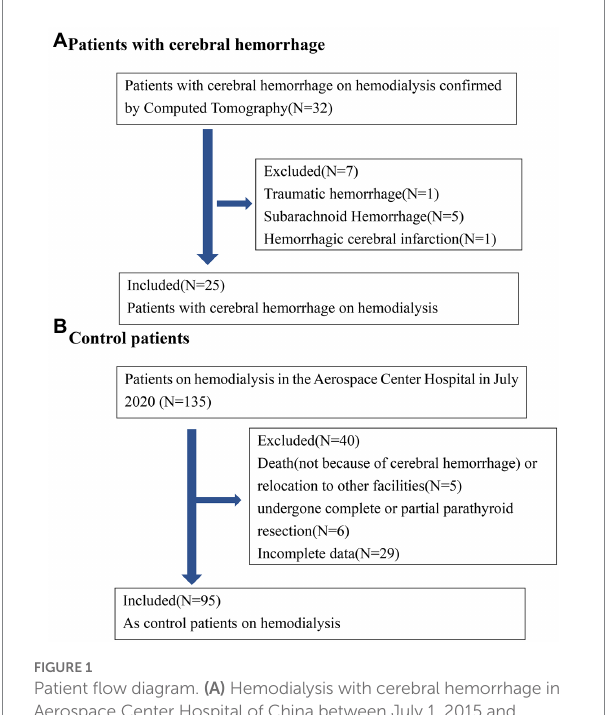
FIGURE 1 Patient flow diagram. (A) Hemodialysis with cerebral hemorrhage in Aerospace Center Hospital of China between July 1, 2015 and October 10, 2022; (B) control hemodialysis patients in Aerospace Center Hospital of China in July